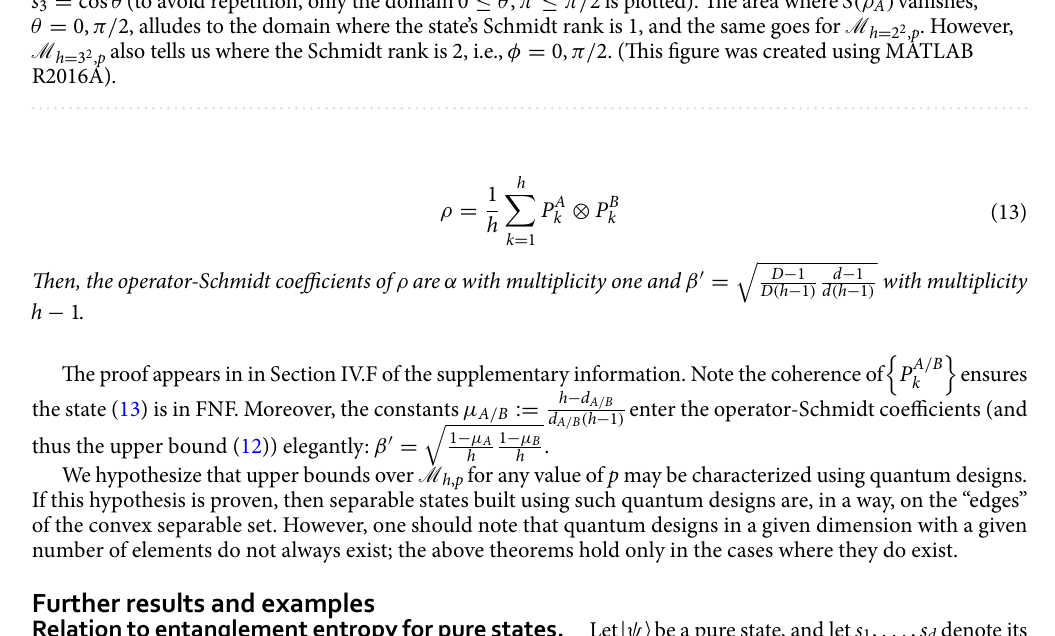
sin θ cos φ , s 2 sin θ sin φ and = = θ , π π/ 2 is plotted). The area where S (ρ A ) vanishes, ≤ ≤ 2 2 , p . However, h =